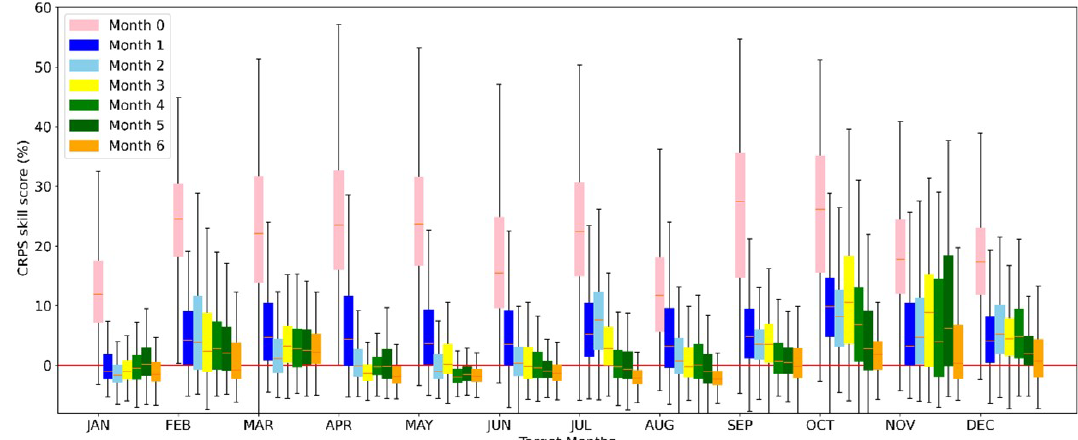
Figure 6. Box plot of CRPS skill score by target month in BJP-ti calibrated